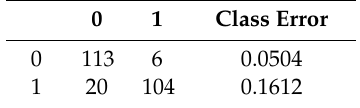
Table 6. Confusion matrix from the RF model (0 = no landslide, 1 = landslide).